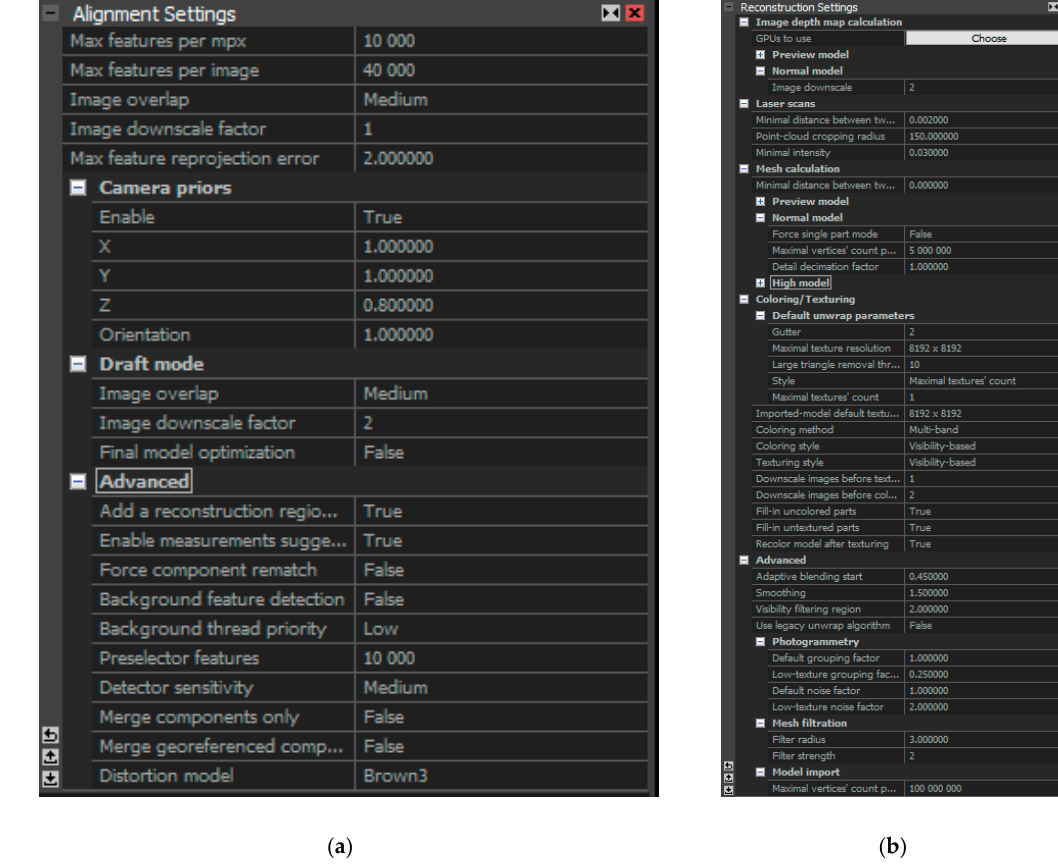
Figure A1. ( a ) Alignment Settings and ( b ) Reconstruction Settings.